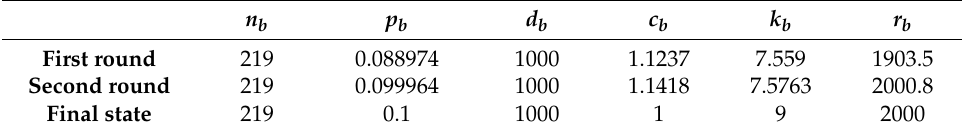
Table 5. Optimized networking parameters of UWSN.